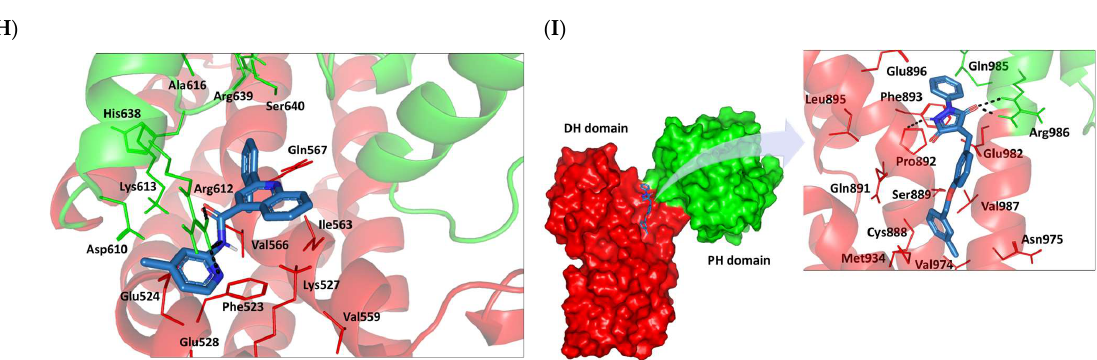
Figure 11. Docked binding modes and interactions for investigated small molecules at ECT2 cata- lytic DH-PH interface. ( A ) Overlay of docked small molecules (blue sticks) at ECT2 catalytic inter- face (PDB; 6L30) shown in surface representation and colored according to domain (DH and PH domains as red and green, respectively). Zoomed image defines the assigned DH-PH interface en- dorsed by α3, α5, α6 helices (DH domain) and αN, αC, β1-4 sheet loops (PH domain). ( B – H ) Pre- dicted binding modes of the docked ligands (blue sticks); ( B ) SM1, ( C ) SM2, ( D ) SM3, ( E ) SM4, ( F ) SM5, ( G ) SM6, and ( H ) SM7 at ECT2 catalytic interface binding site. ( I ) Replicated binding mode of SM1 at LARG RhoGEF (PDB; 1X86) as reported in the literature. Residues (lines) within a radius of 5 Å from the bounded ligands are displayed, colored with regard to their position at the catalytic domains and labeled with a sequence number. Black dashed lines represent the polar ligand–target interactions.